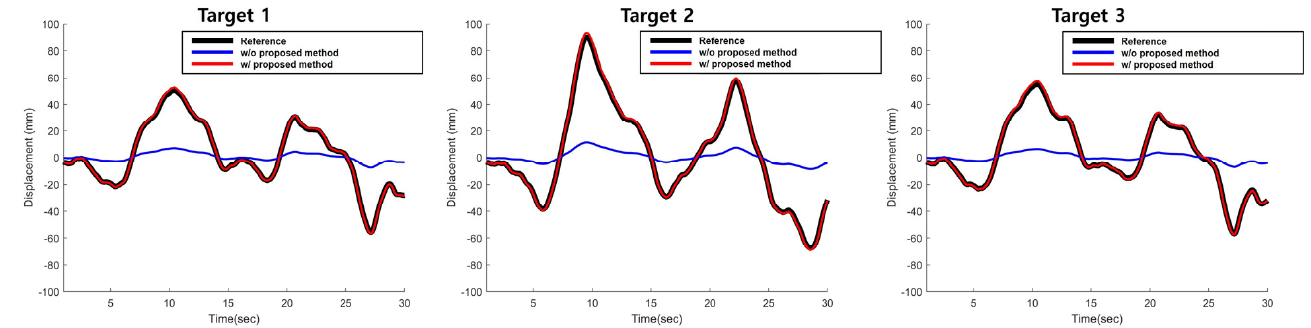
Figure 8. Estimated displacement for the simulation-based validation test. The RMSE (root mean square error) of the displacement is shown in Table 1. The proposed method showed RMSE of 0.7001 mm, 1.2789 mm and 0.9579 mm, respectively, for each target, while the RMSE of the displacement without proposed method were of 20.6601 mm, 32.6588 mm and 22.6273 mm. The proposed method could reduce the aver- age RMSE from 25.3154 mm to 0.9790 mm. Table 1. RMSE of the estimated displacement with and without proposed method.